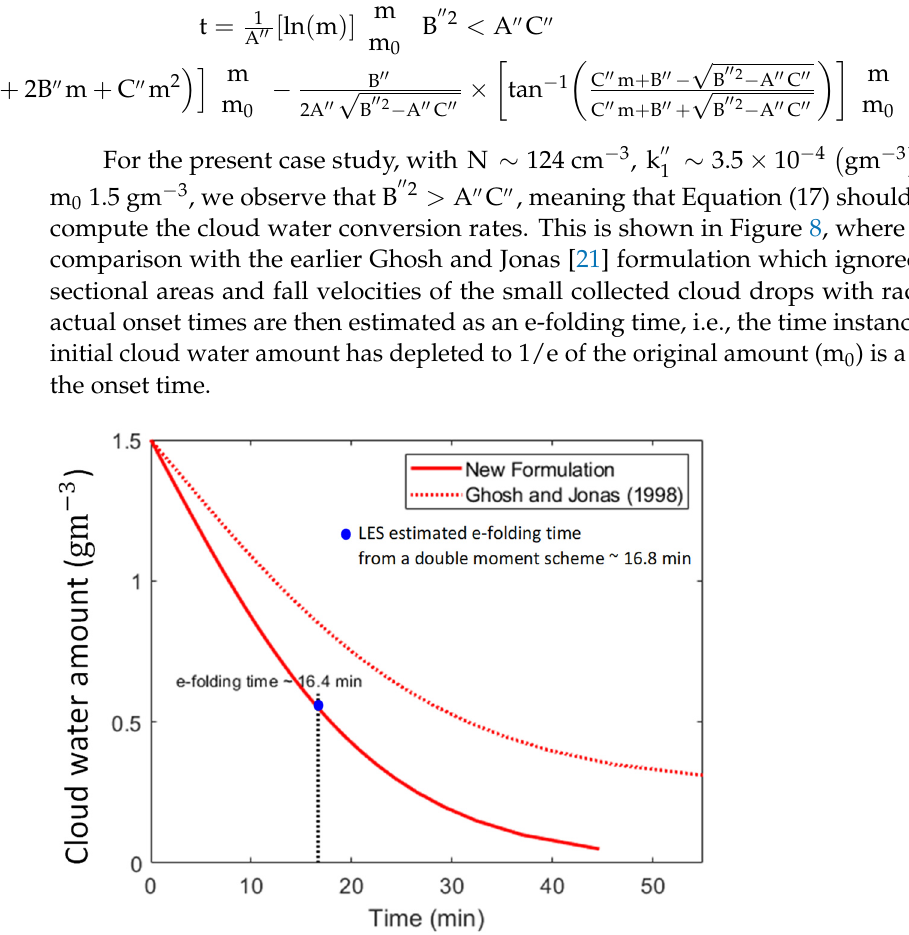
Figure 8. Onset time of precipitation estimated from analytical solutions (Equation (14a)) and the original Ghosh and Jonas (1998) calculations.